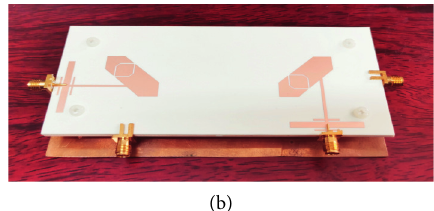
Figure 11: MIMO antenna layout: (a) top view; (b) fabrication.